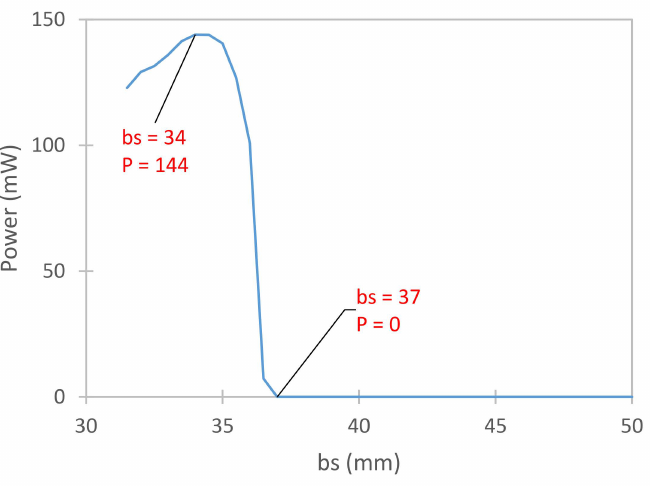
Figure 12. Graph Showing Variation of Power Output with Substrate Layer Width b s . The optimal value of the thickness of the substrate layer h s , ranging between 0.1 mm and 10 mm with 0.1 mm steps, is observed in Figure 13 to be 6 mm. At 6.4 mm, and for